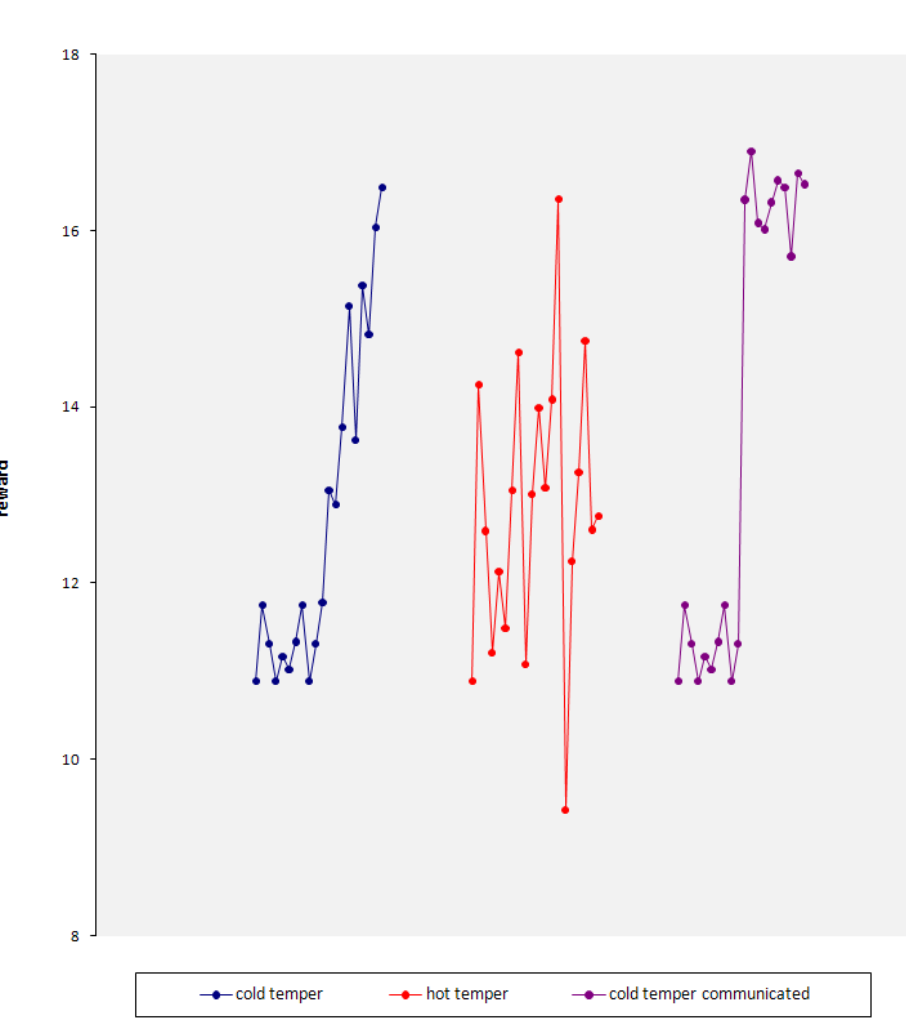
Figure 12. Observed reward for robots with different tempers (constant background